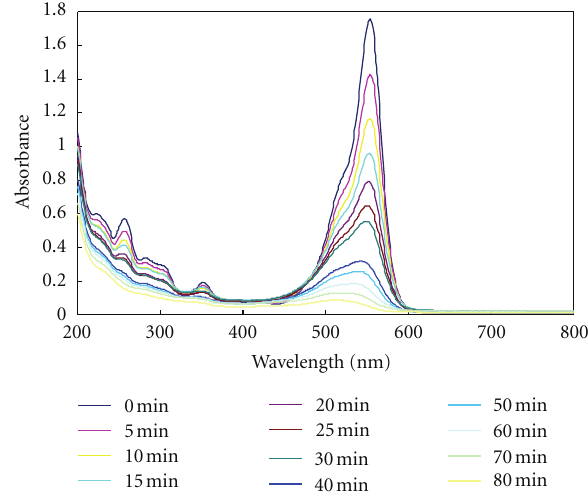
Figure 6: Influence of Cl − , H 2 PO 4 − and HCO 3 − anions on the degradation of with UV/K 2 S 2 O 8 system. Conditions: [RhB] = 0.02mM, [K 2 S 2 O 8 ] = 0.4 mM.